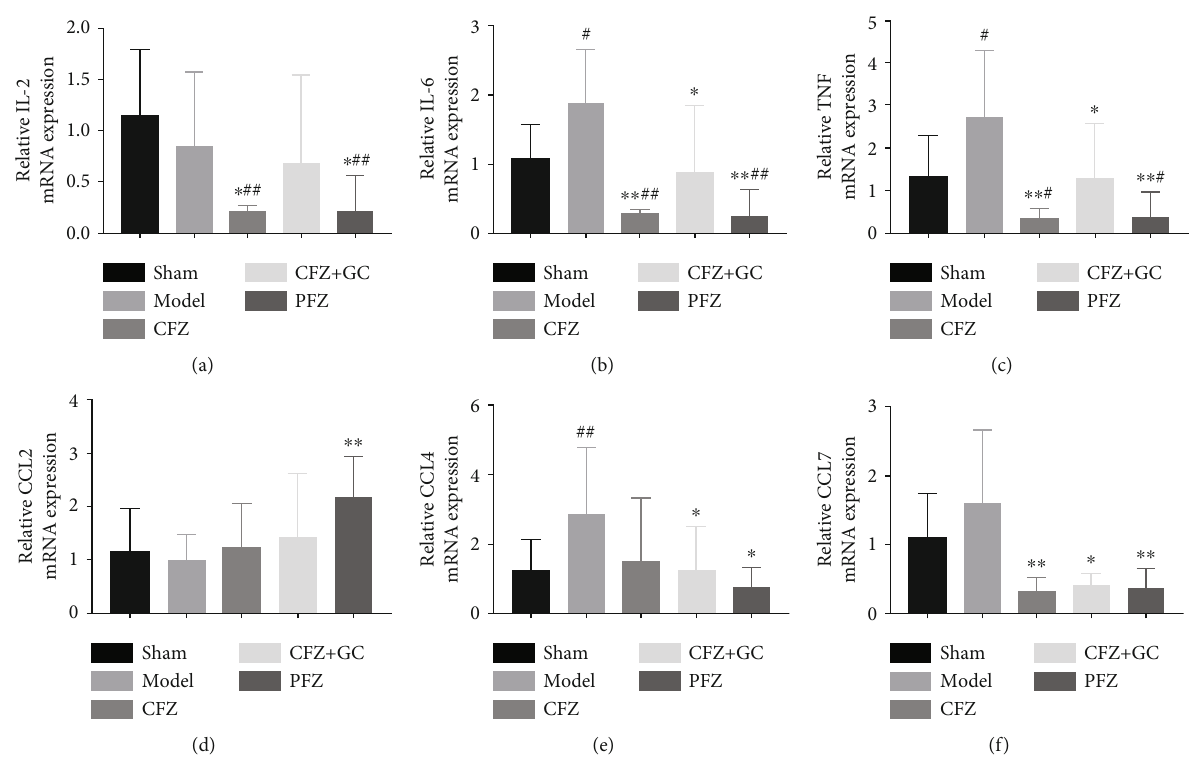
Figure 7: The mRNA expression of in fl ammatory factors and chemokines in heart of each group: (a – f) in fl ammation factors interleukin- (IL-) 2, tumor necrosis factor- (TNF-) α , IL-6, and chemokine ligand (CCL) 2, CCL4, and CCL7 mRNA levels, respectively. All data are presented as mean ± SD ( n ≥ 5 /group). # P < 0 : 05 and ## P < 0 : 01 versus the sham group; ∗ P < 0 : 05 and ∗∗ P < 0 : 01 versus the model